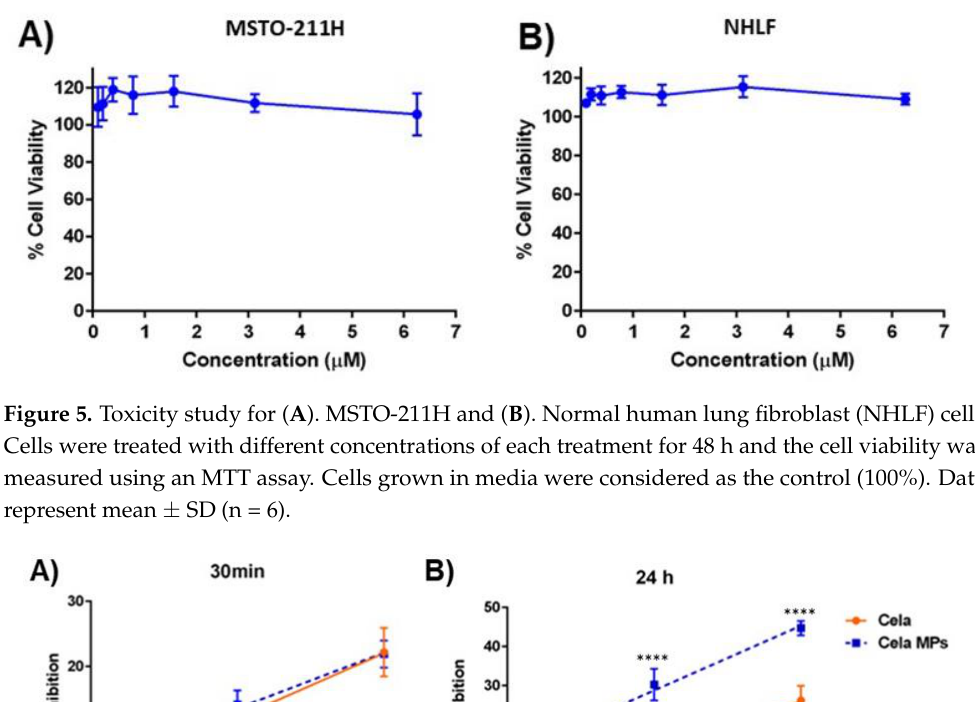
Figure 5. Toxicity study for ( A ). MSTO-211H and ( B ). Normal human lung fibroblast (NHLF) cells. Cells were treated with different concentrations of each treatment for 48 h and the cell viability was measured using an MTT assay. Cells grown in media were considered as the control (100%). Data represent mean ± SD (n = 6).